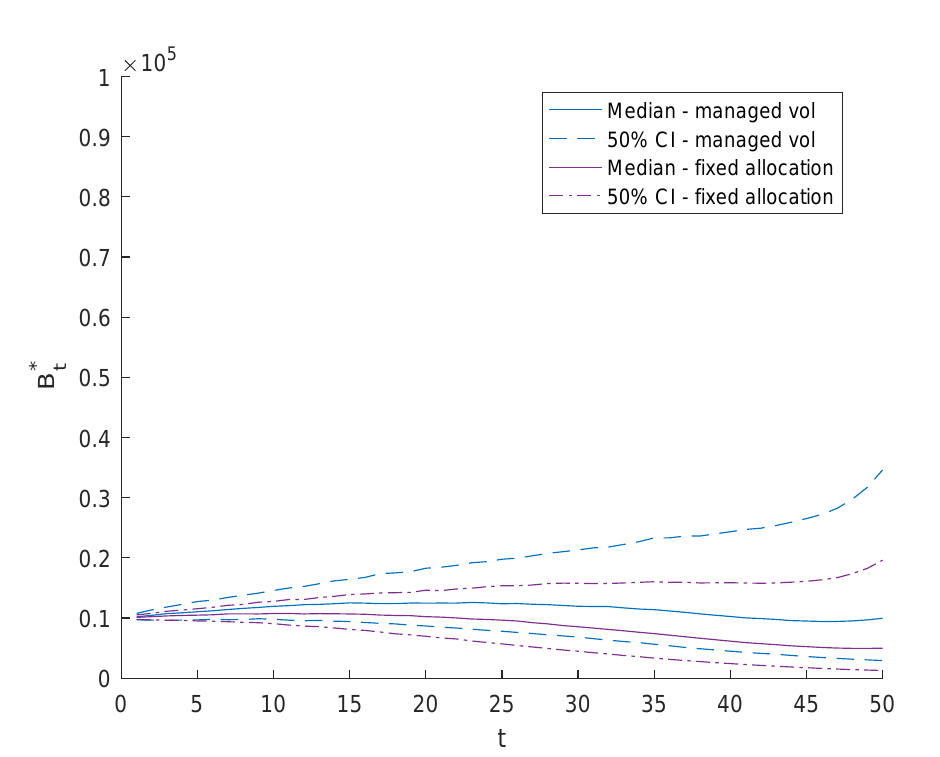
Figure 3. The 50% confidence interval of annuity payments. Managed-Volatility vs. Fixed Allocation (65%/35%)—Nominal.